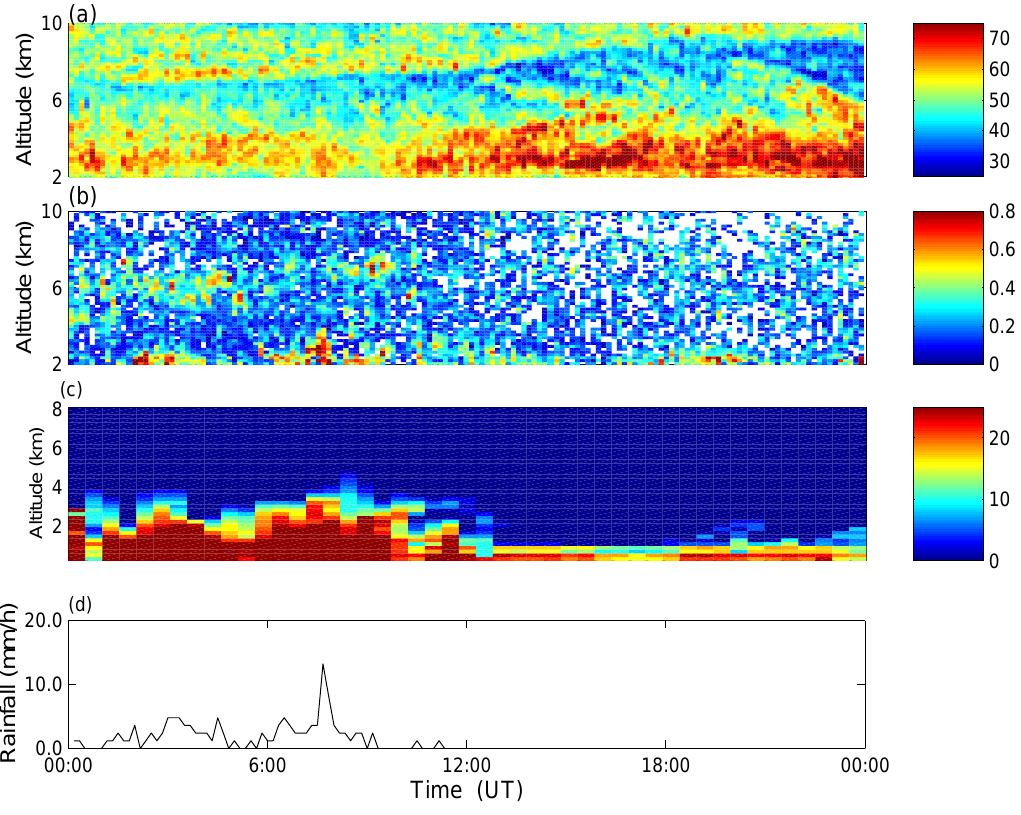
Fig. 1. Time-height contour plots of ( a ) vertical signal power (dB), ( b ) vertical corrected spectral width (m s − 1 ) observed by the VHF radar, ( c ) the vertical signal-to-noise ratio measured by a co-located UHF wind profiler (dB) and ( d ) the variation of surface rainfall observed by a tipping bucket rain gauge on 17 May